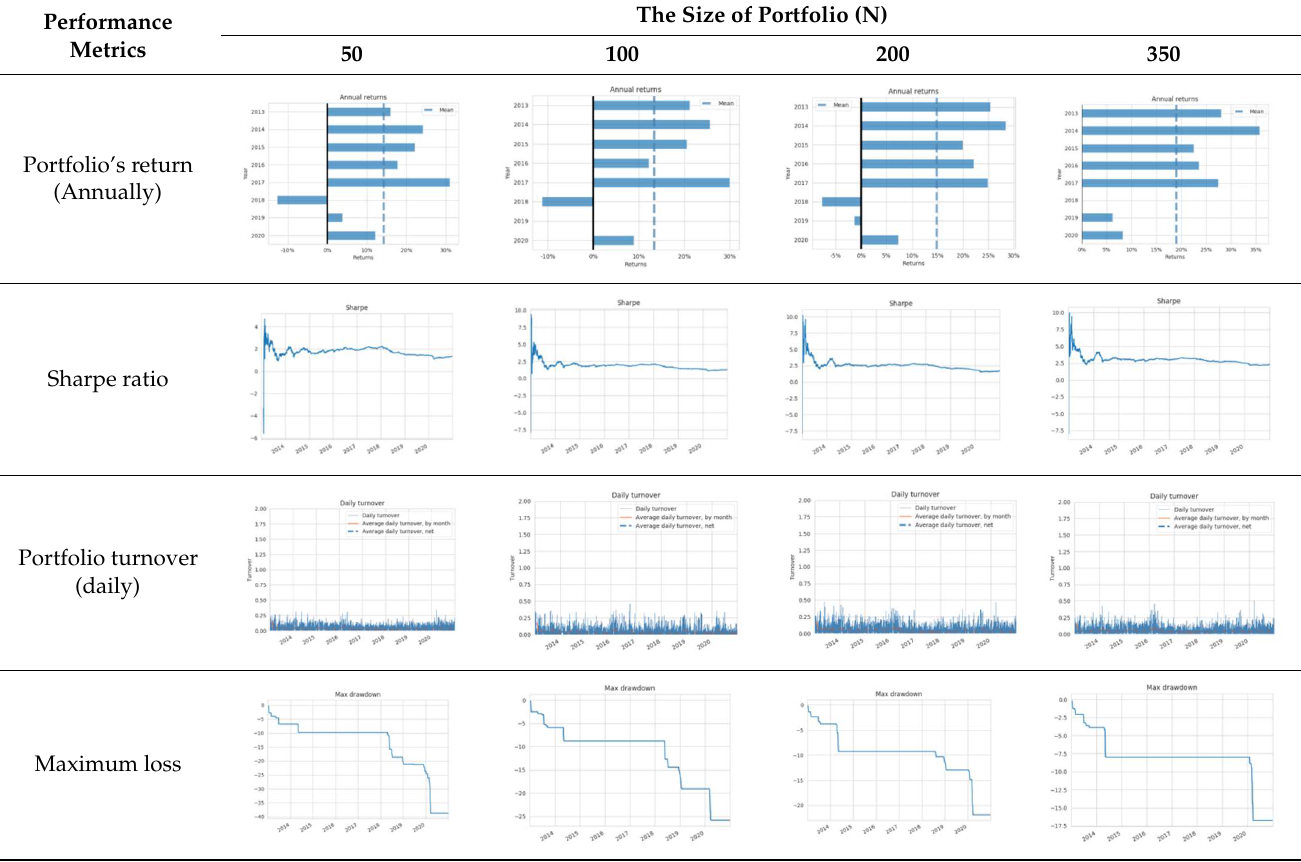
Table 4. The performance of the shrinkage on out—of—sample from 1 January 2013–1 January 2021.